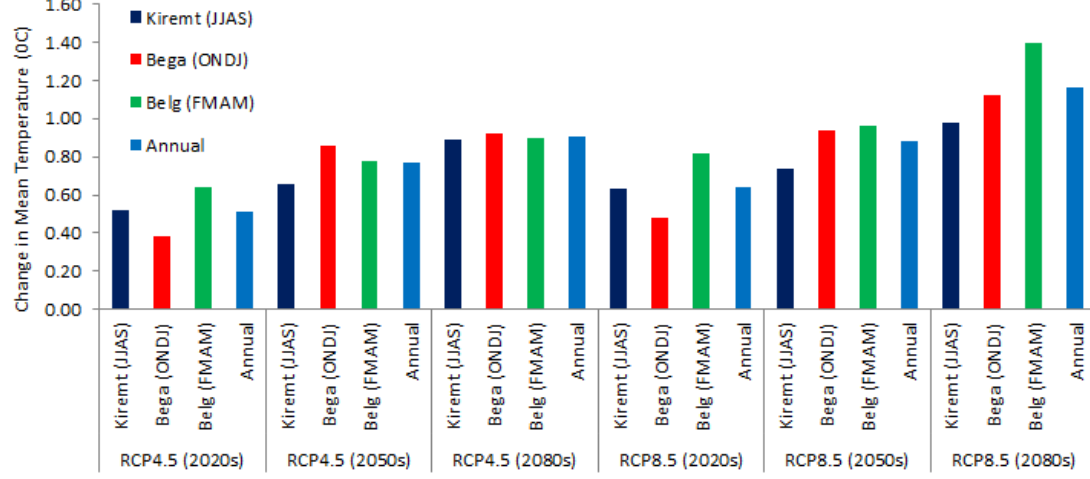
Figure 7. Change in seasonal and annual temperature for three time periods under RCP4.5 and RCP8.5.